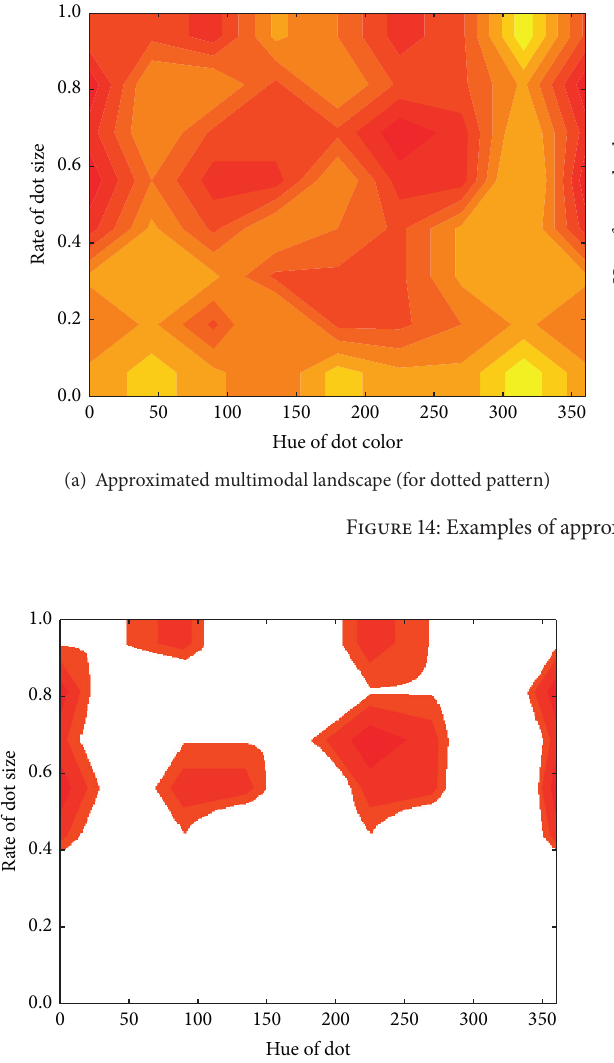
Figure15:PeaksinthemultimodallandscapeshowninFigure 14(a).